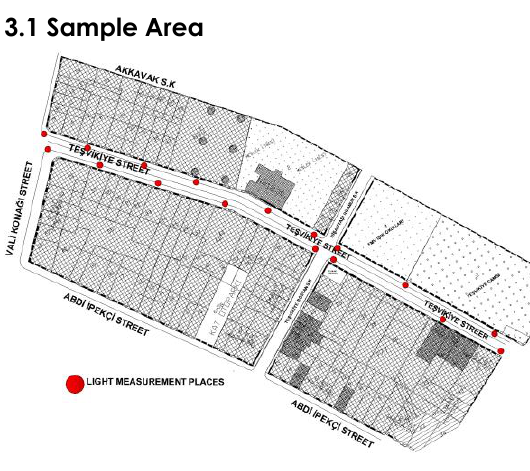
Figure 4. Teşvikiye Street (studied by authors)